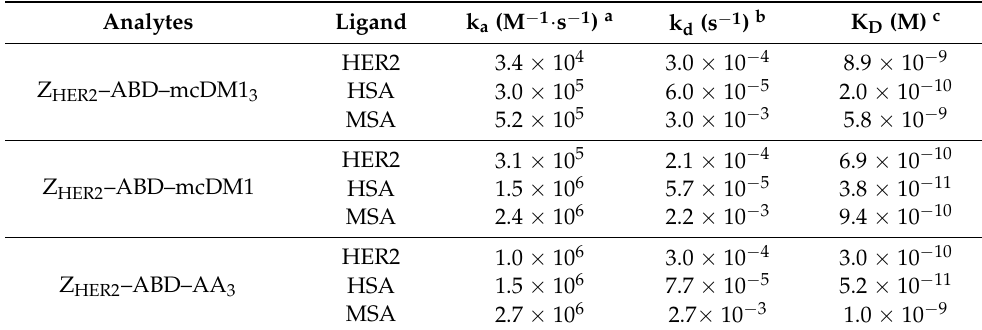
Figure 3. Biosensor analysis. Two-fold serial dilutions of the conjugates indicated over each panel were sequentially injected over flow-cells with immobilized recombinant HER2 ( A ), human serum albumin (HSA) ( B ), and mouse serum albumin (MSA) ( C ). Each concentration was injected twice, and each panel is an overlay of all recorded sensorgrams for each conjugate. The recorded sensorgrams are displayed in black, and the biosensor’s best fitting of the data is shown in red. The concentrations of the injected dilution series are indicated to the right of each panel. Table 1. Kinetic parameters and equilibrium dissociation